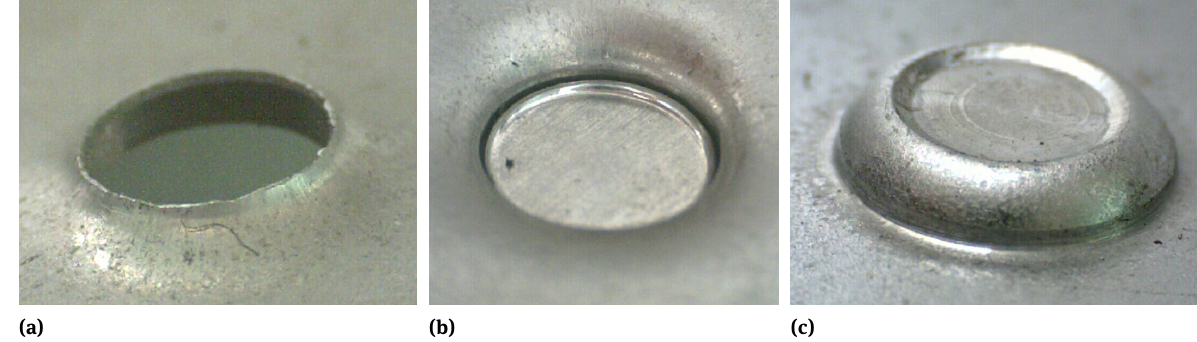
Figure 4: Joint with DP780 sheets after clinching: (a) top sheet, (b) middle sheet, (c) bottom sheet.